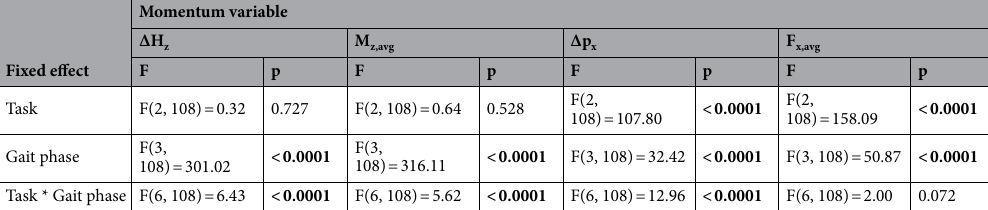
Table 1. Statistical results for the original linear mixed model (omnibus test). Significant values are in bold.